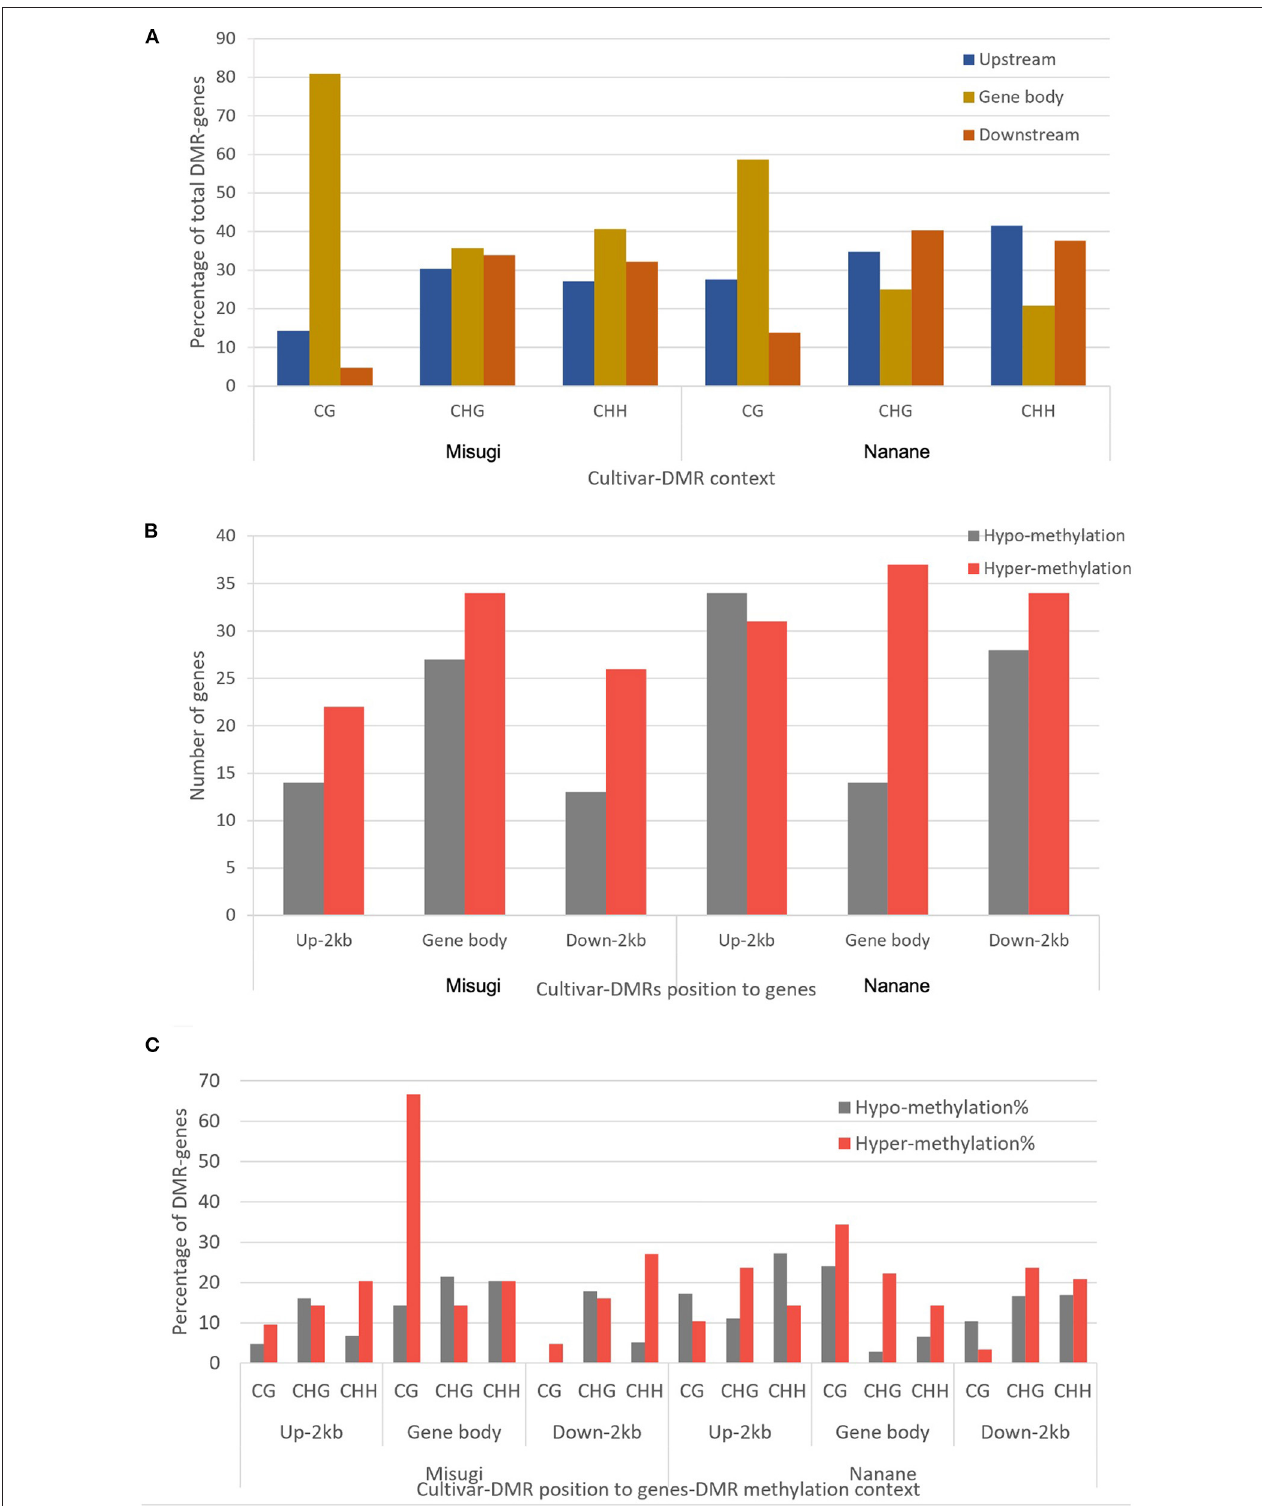
FIGURE 5 | Proximate location and methylation status of differentially methylated regions (DMRs) in B. rapa cultivars “Misugi” (susceptible) and “Nanane” (resistant). (A) Percentage of 136 and 178 genes associated with DMRs in “Misugi” (susceptible) and “Nanane” (resistant), respectively. (B) Total number of genes associated with hypo and hyper DMRs at each proximate location (i.e., gene body and/or up to 2kb upstream and downstream of genes). (C) Percentage of DMR-associated genes with hypo- and hyper-methylated CG, CHG, and CHH DMRs.